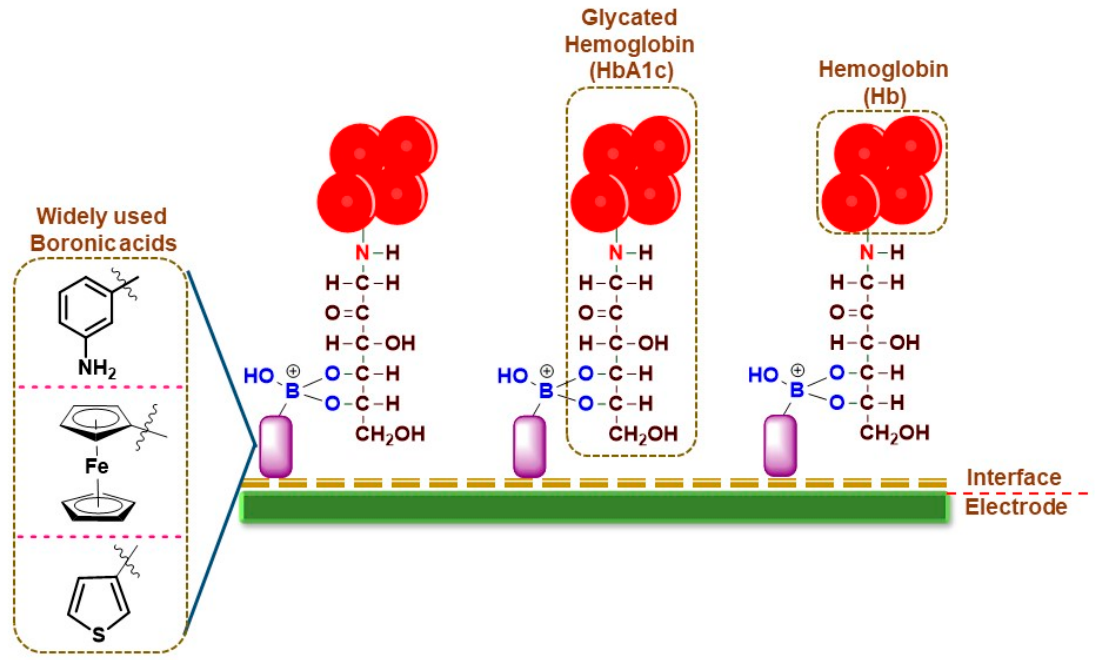
Figure 2. Pictorial representation of broadly used boronic acid-assisted electrochemical sensors for HbA1c detection.